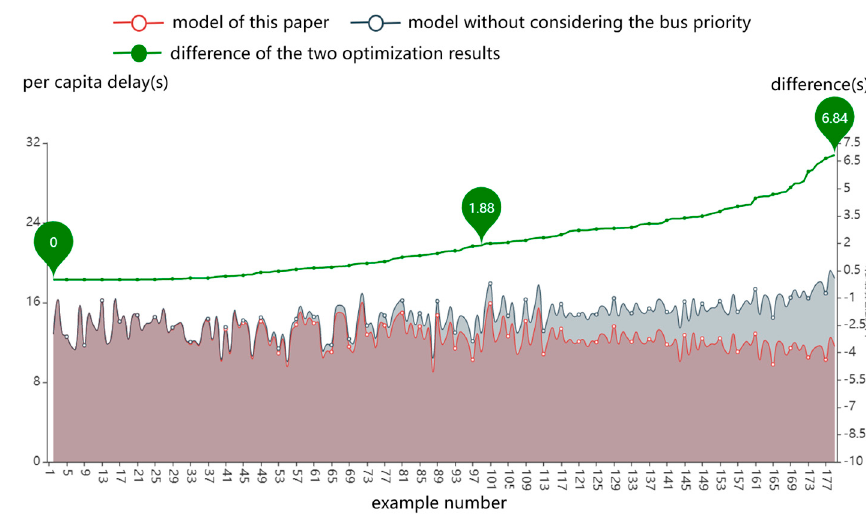
Figure 14. Comparison of per capita delay after the optimization of the two models.